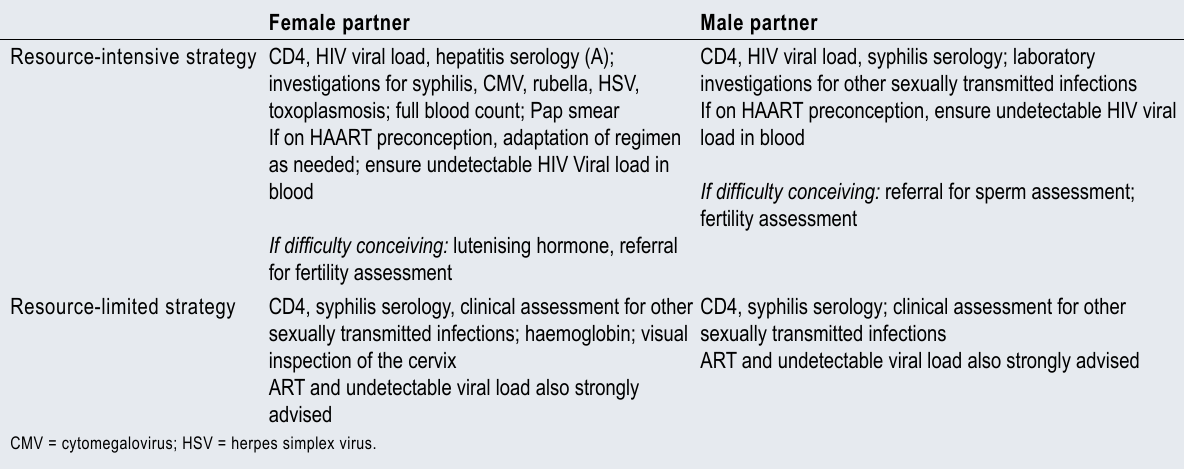
TABLE II. PRECONCEPTION WORK-UP FOR HIV-INFECTED INDIVIDUALS DESIRING A CHILD IN RESOURCE- INTENSIVE AND RESOURCE-LIMITED